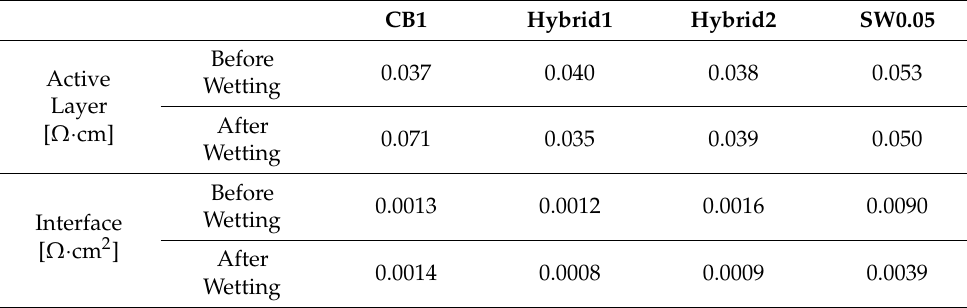
Table 2. Resistivity and resistance of